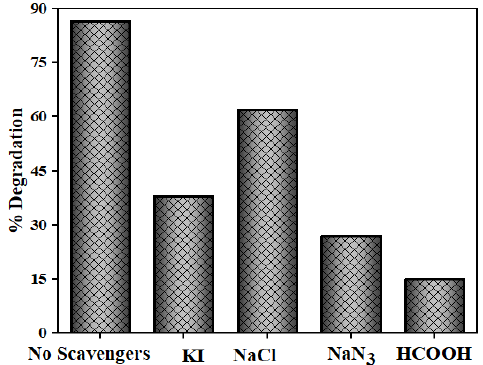
Figure 18. Photocatalytic degradation of NOFX with different scavengers.